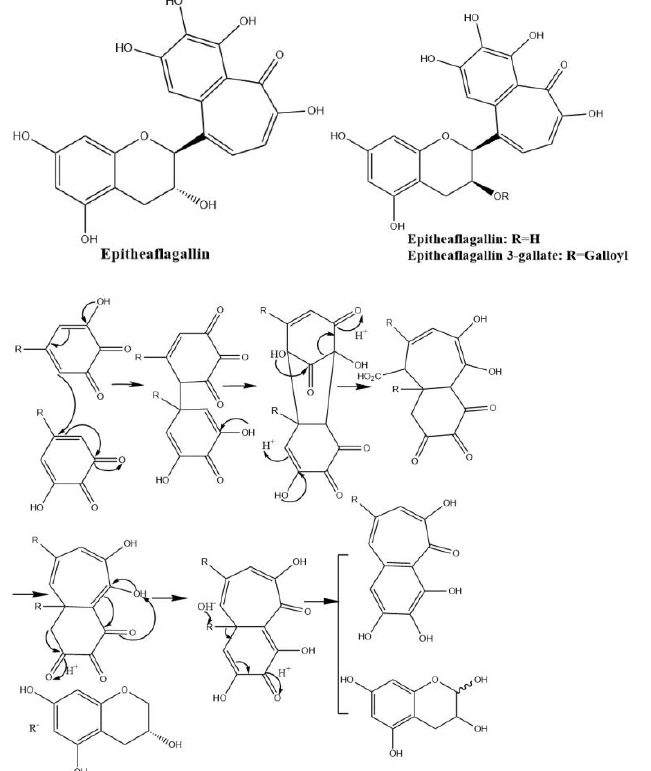
Figure 7. The structures of theaflagallinas and proposed mechanisms for production of epi- theaflagallin.